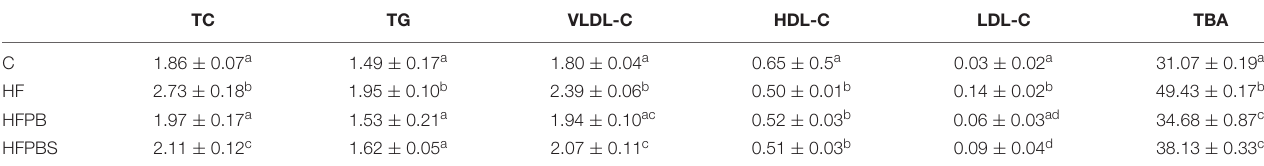
TABLE 4 | Serum physiological and biochemical